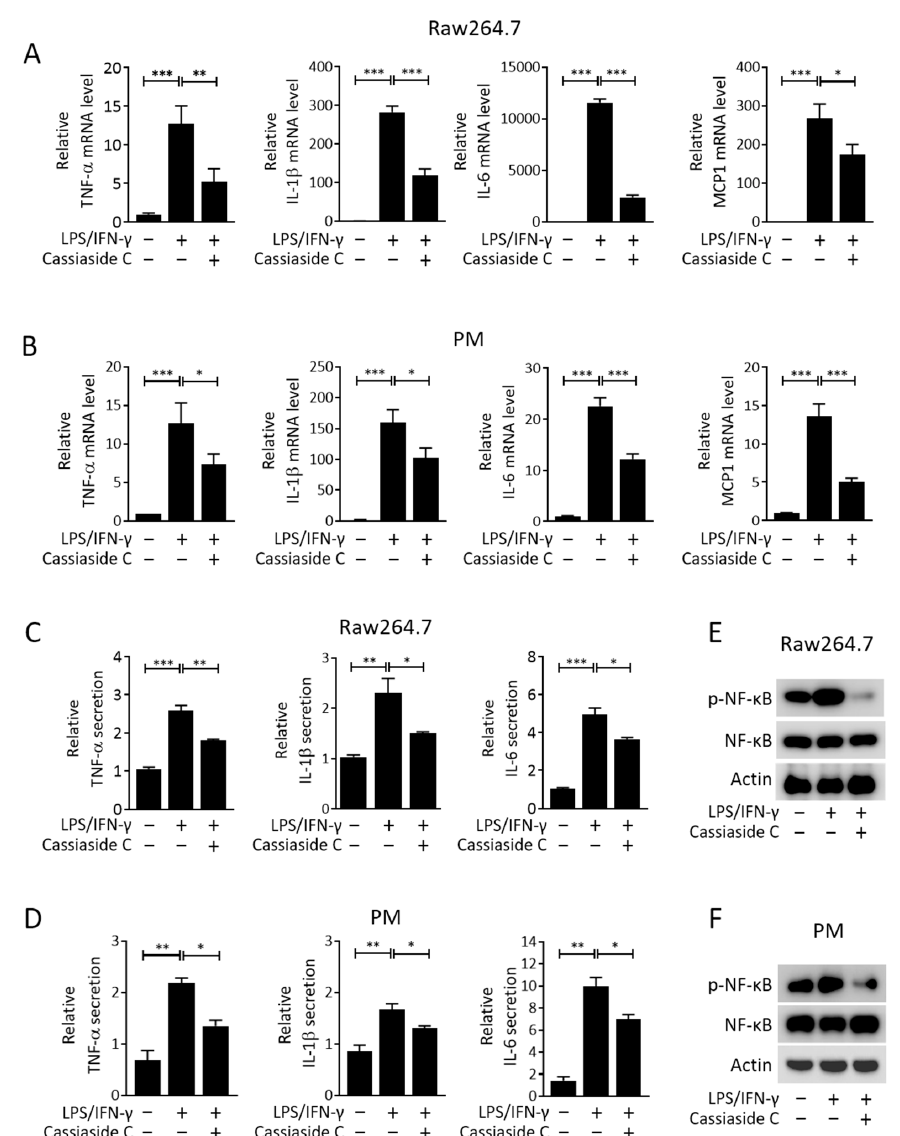
Figure 2. Cassiaside C suppresses LPS/IFN- γ -stimulated pro-inflammatory cytokine expression and secretion by macrophages. ( A , B ) Effects of Cassiaside C on TNF- α , IL- β , IL-6, and MCP-1 mRNA expression in LPS/IFN- γ -stimulated Raw264.7 cells and PMs. ( C , D ) Effects of Cassiaside C on secretion of TNF- α , IL- β , and IL-6 in LPS/IFN- γ -stimulated Raw264.7 cells and PMs. ( E , F ) Effects of Cassiaside C on phosphorylated NF- κ B in LPS/IFN- γ -stimulated Raw264.7 cells and PMs. Data are expressed as the mean ± SEM ( n = 3 technical replicates). * p < 0.05, ** p < 0.01, and *** p < 0.001. PM, peritoneal macrophages.